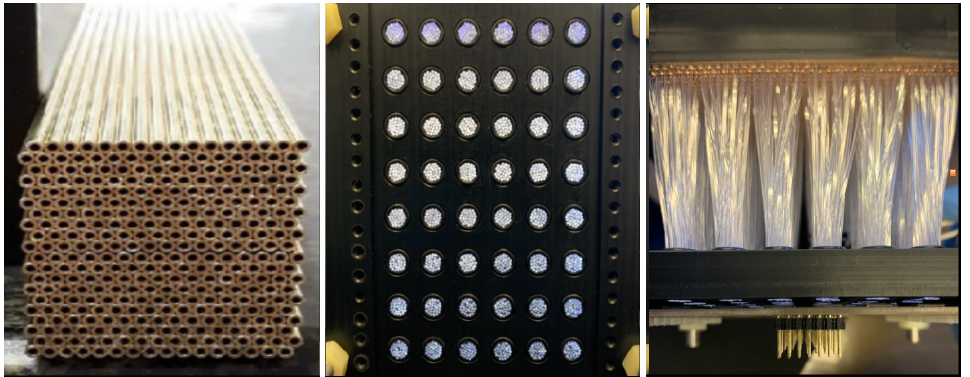
Figure 1. FoCal-H 2021 prototype module with 1440 Cu tubes ( left ), grouped scintillating fibers at the back of the detector ( center ) and 16 (out of 48) mounted Onsemi MICROFC-60035-SMT-TR1 SiPMs at the back of the detector ( right